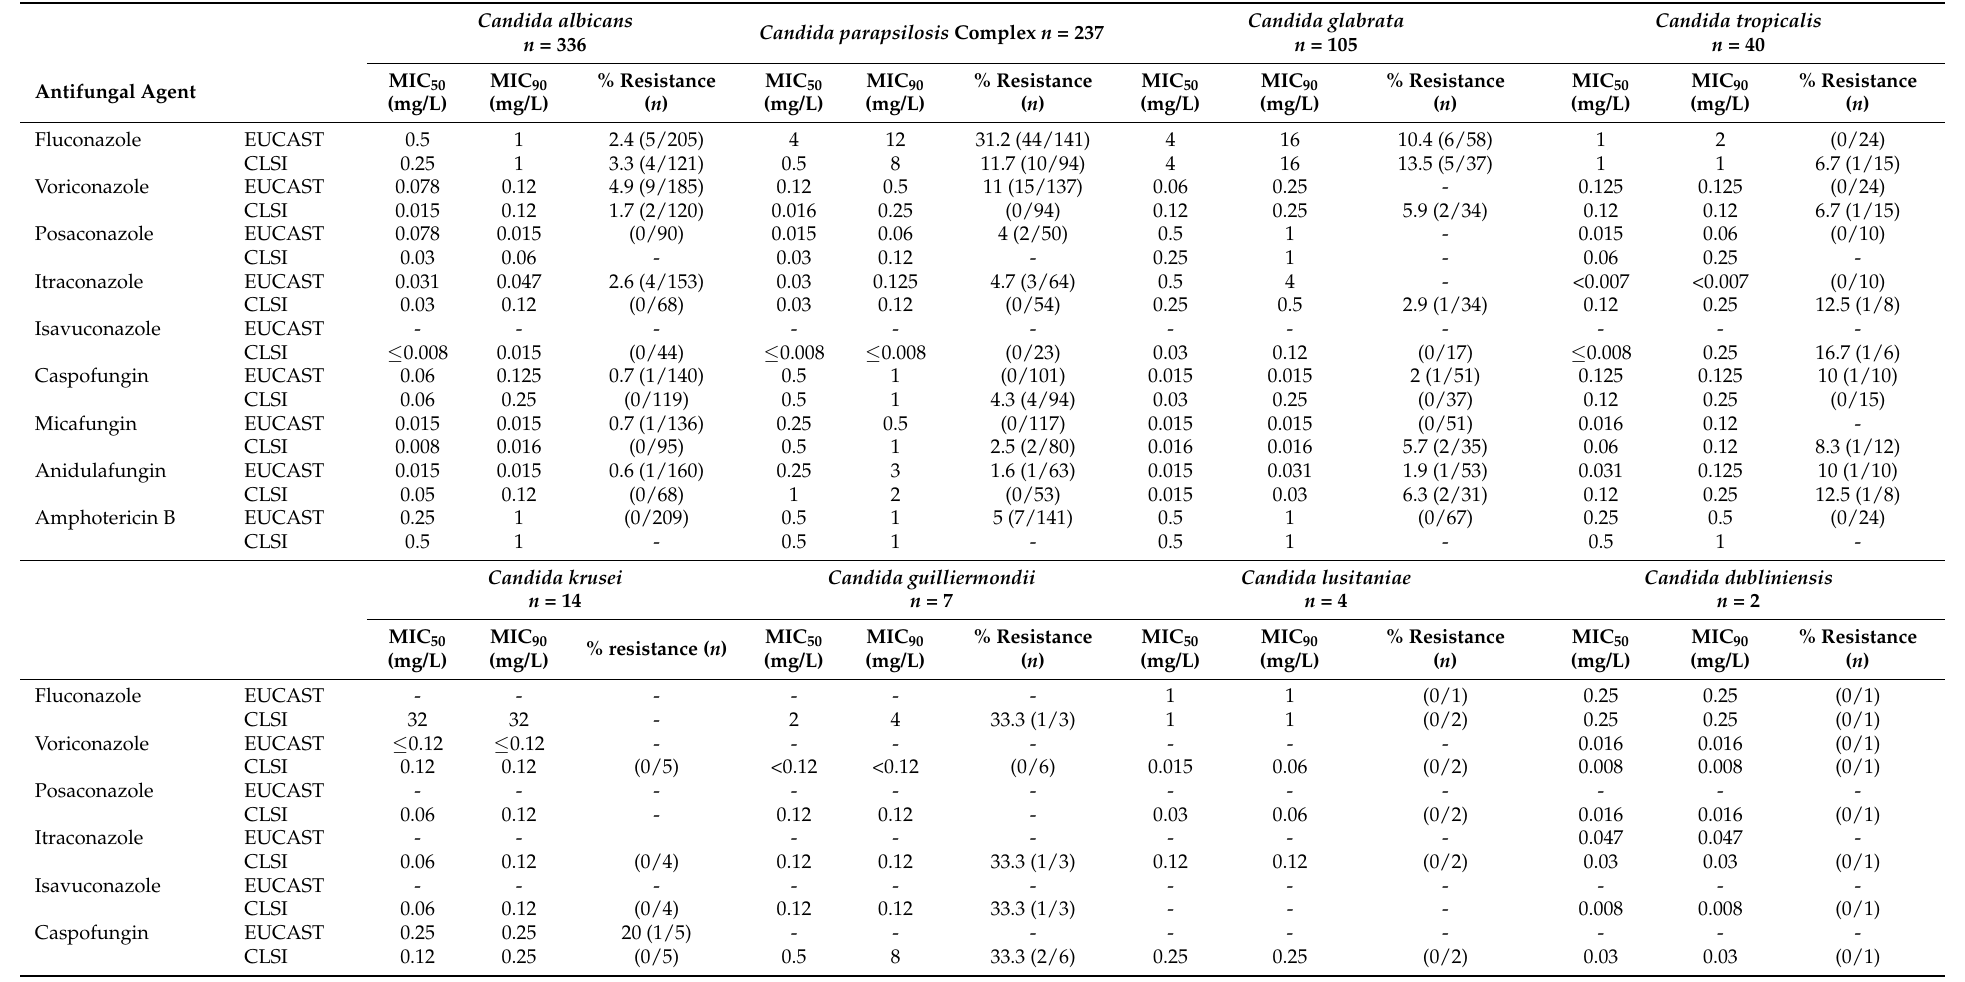
Table 3. Susceptibility testing results of Candida species isolates tested in the